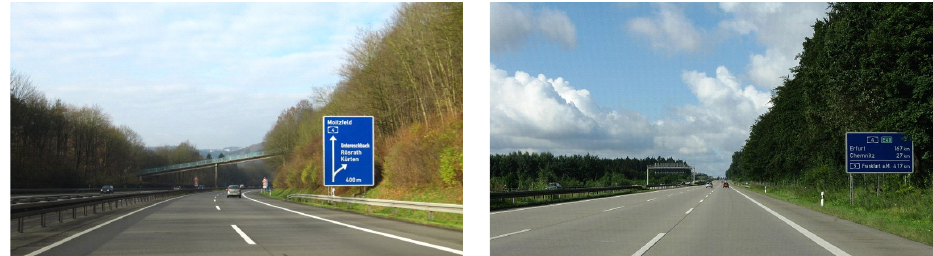
Figure 2. Guardrail and roadside environment at the collection site.